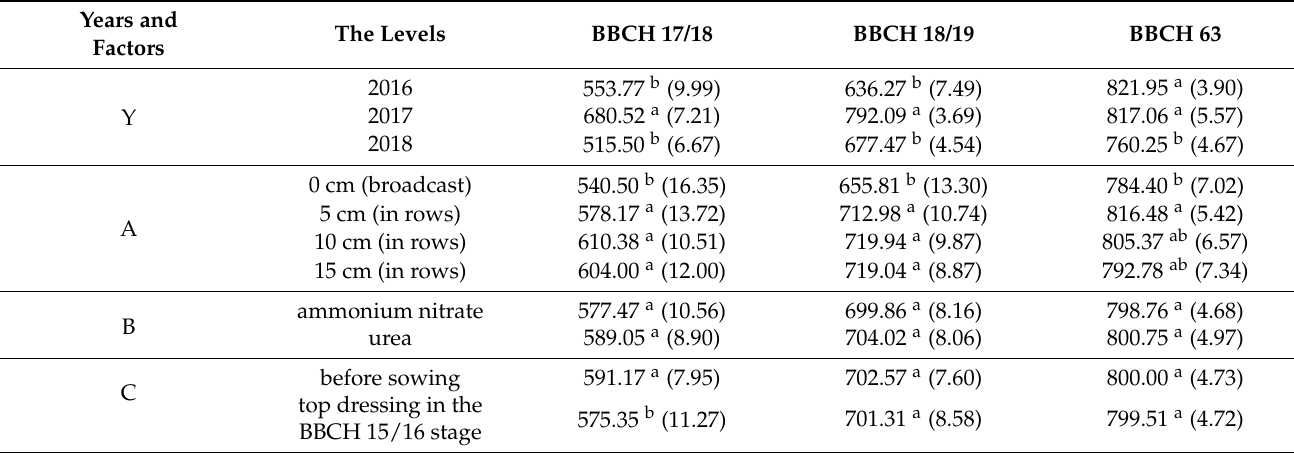
Table 7. Mean values (SPAD) of the traits for the years (Y) and NP fertilizer sowing depth (A), type of supplementary nitrogen fertilizer (B), date of supplementary nitrogen fertilization (C).